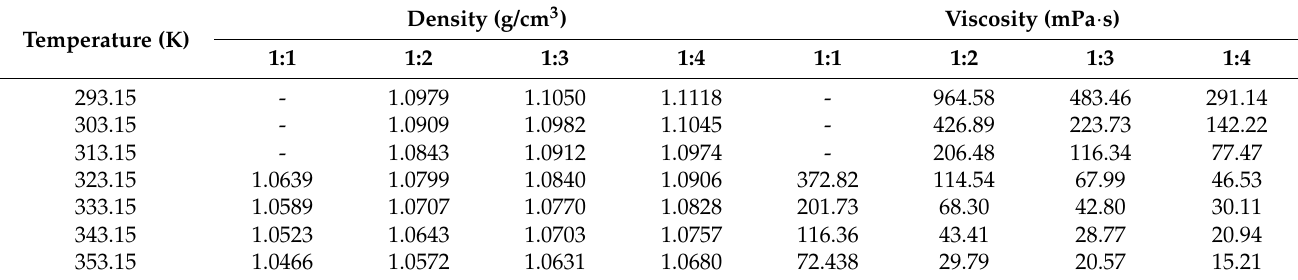
Table 5. Experimental density and viscosity values at different temperatures and atmospheric pressures ( p = 101.325 kPa). Density (g/cm 3 Temperature (K)